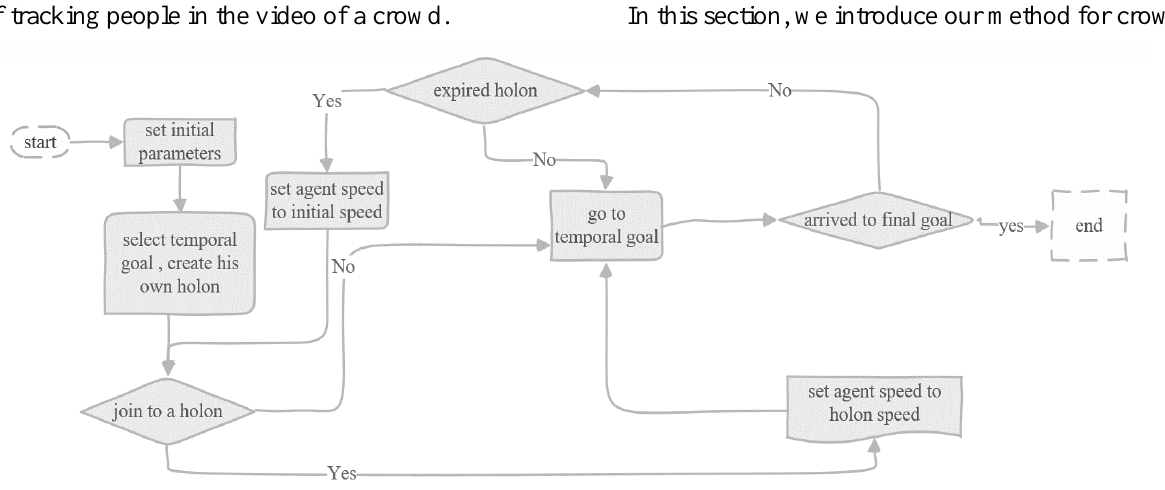
Figure 2. Simulation process for an